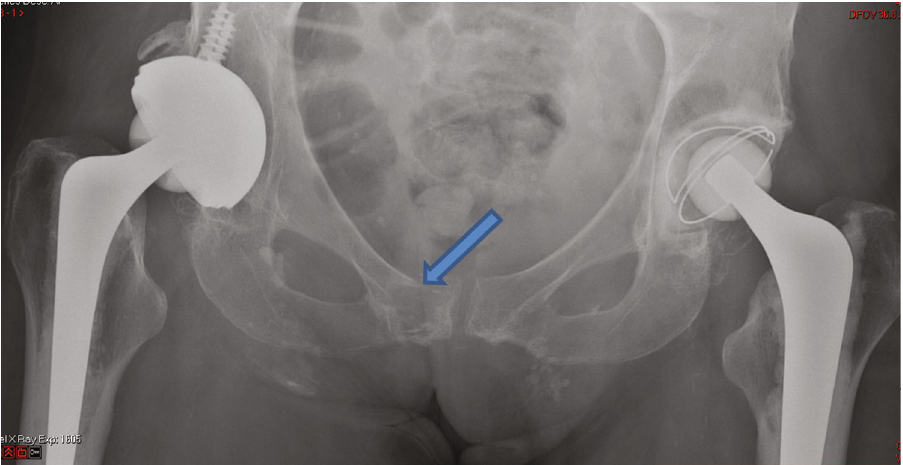
Figure 1: Plain radiograph showing irregularity in the left pubic bone and new bone formation.